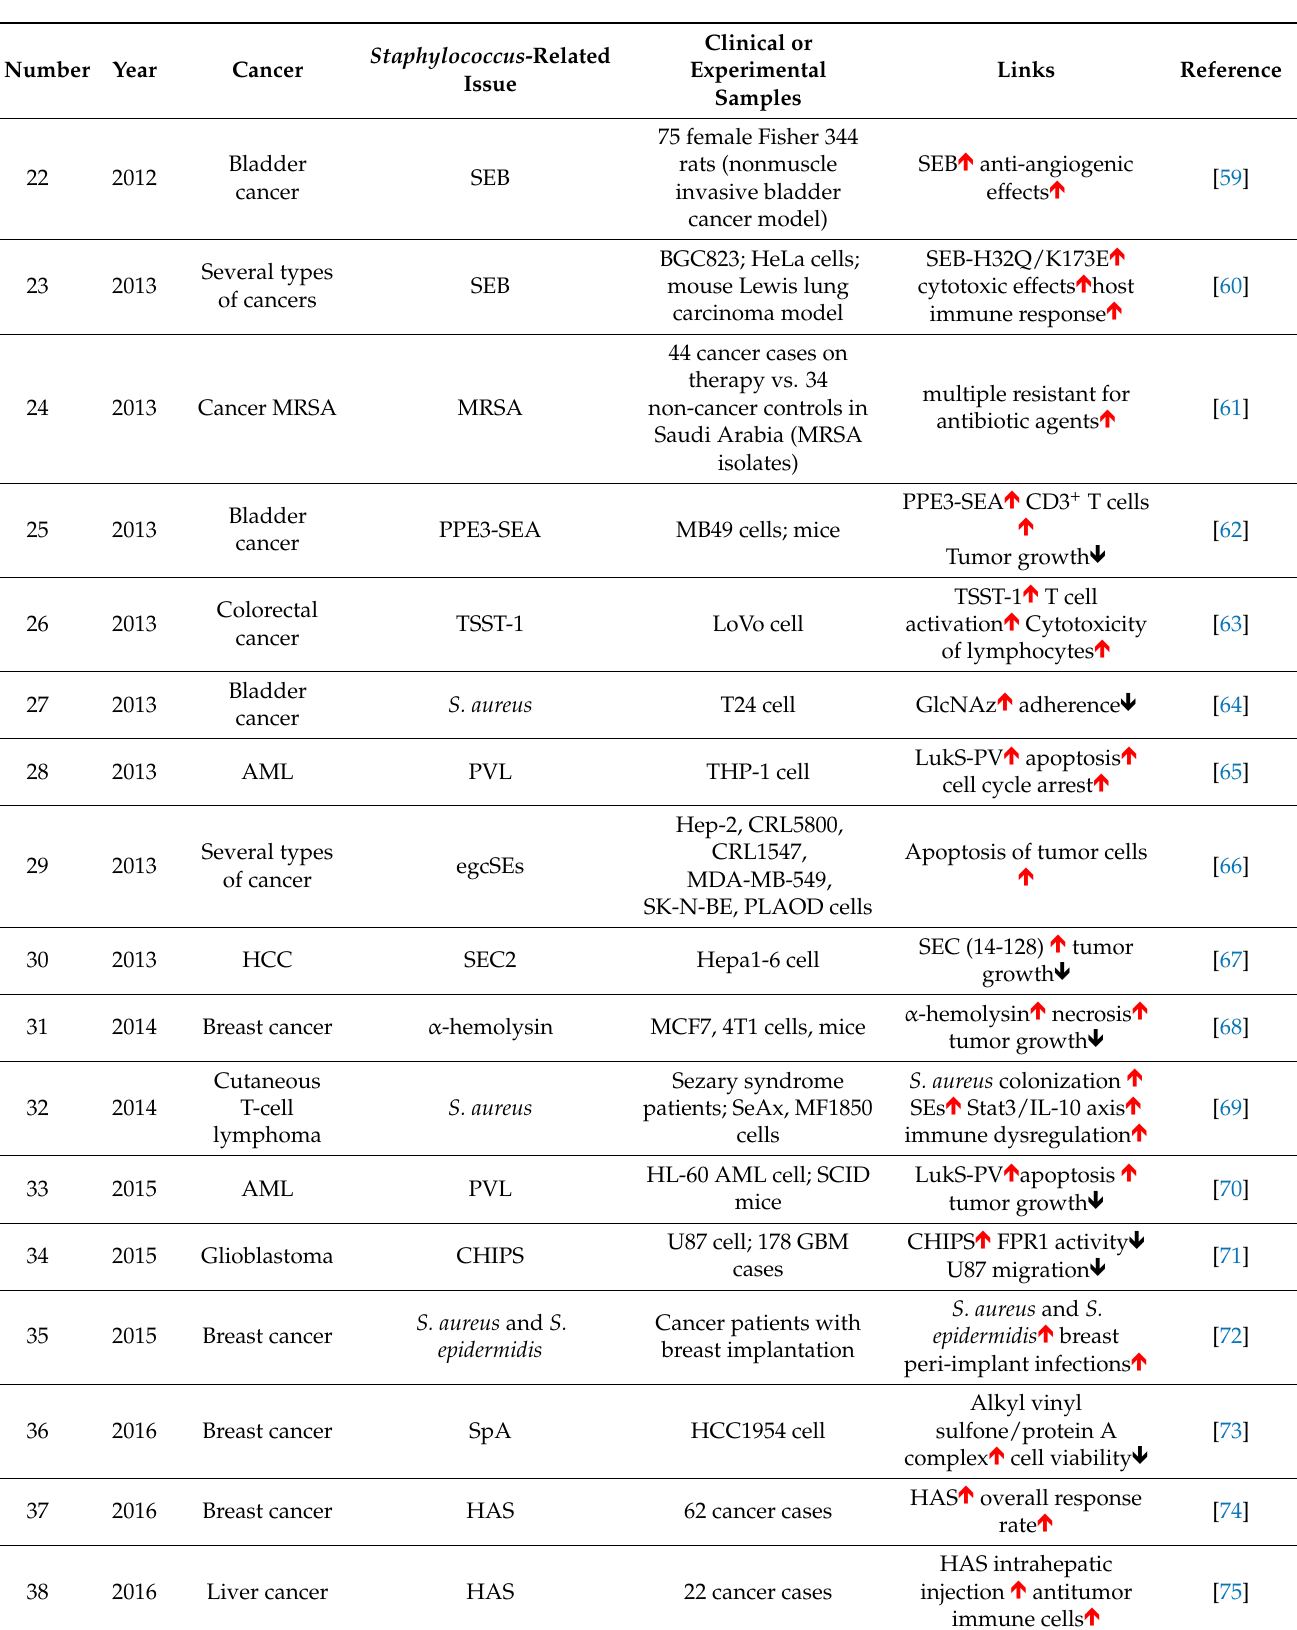
Table 1. Cont. Table 1. Summary of evidence on Staphylococcus and carcinogenesis. Table 1. Summary of evidence on Staphylococcus and carcinogenesis. Table 1. Summary of evidence on Staphylococcus and carcinogenesis. Table 1. Summary of evidence on Staphylococcus and carcinogenesis. Table 1. Summary of evidence on Staphylococcus and carcinogenesis.